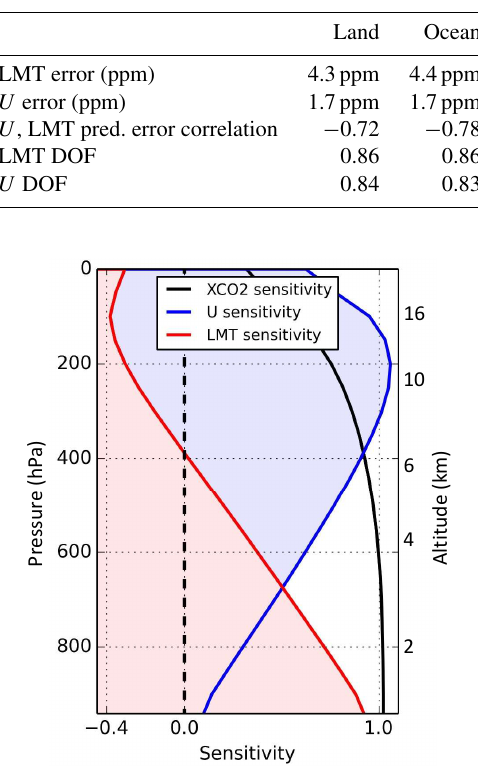
Figure 3. Sensitivity of X CO 2 (black), partitioned into the LMT (red) and U (blue) partial columns for an average land averaging kernel. The LMT sensitivity is approximately 1 near the surface and drops off steadily with decreasing